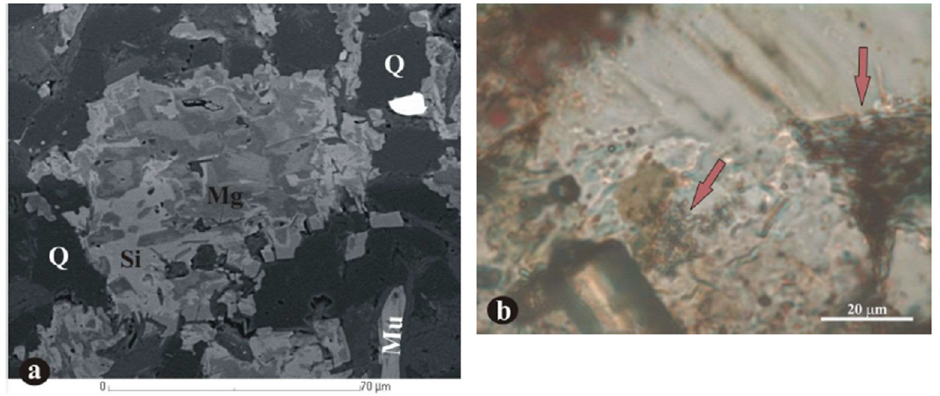
Figure 5. Microtextural images. EPMA image ( a ), legend: Q: quartz grains; Si: siderite; Mg: magnesite; Mu: muscovite. Optical rock microscope image ( b ), microbial filamentous forms on a similar part, with different magnification. Though not exactly the same parts are shown on the photos, it is obvious that the optical rock microscopy (OM) photo shows more fine details of mineralized biosignatures (arrows) (Figure 2e,f, iron ore, [67], with permission of Elsevier Publishing House).